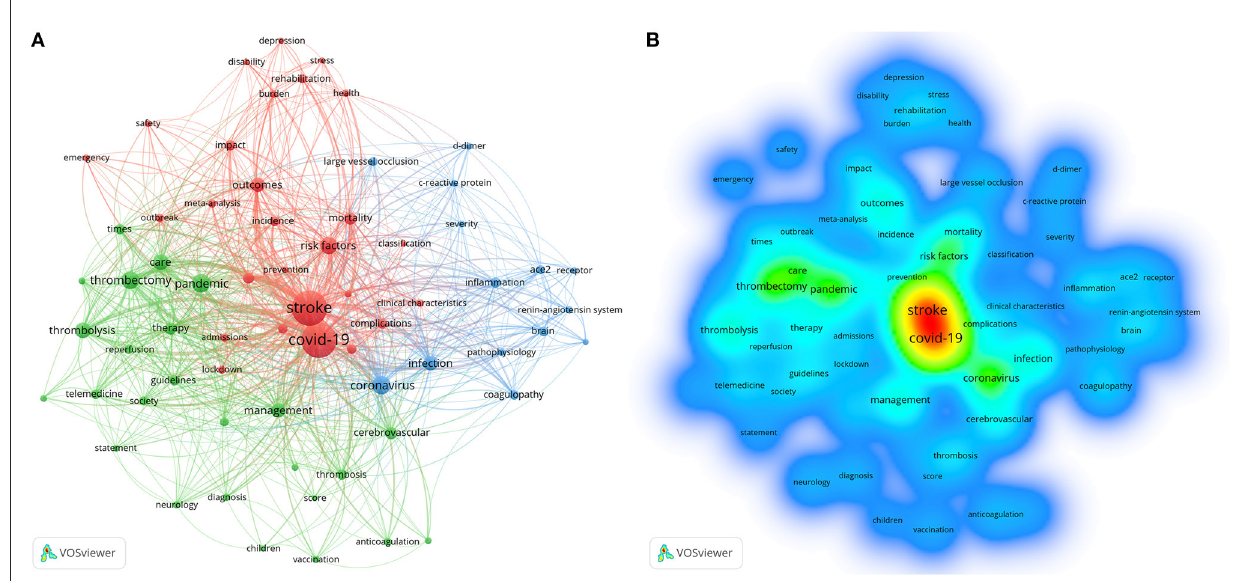
FIGURE5 Sixty-six keywords with five or more occurrences were identified by VOSviewer. (A) Keyword co-occurrence network in COVID-19 and stroke studies. The size of the nodes represents the number of keyword occurrences, and the distance between the nodes and the thickness of the line between the nodes represent the frequency of concurrent occurrences of two keywords. (B) Density diagram of keywords in COVID-19 and stroke studies. Both the color and font size indicates the frequency of keyword occurrence.